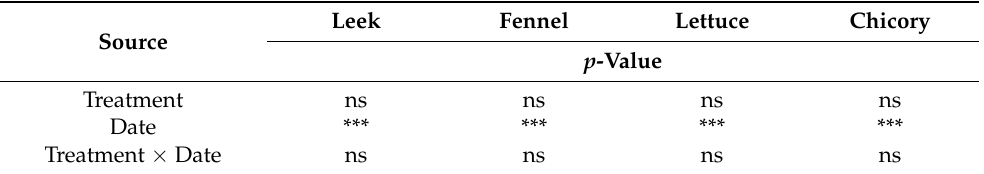
Table 2. Results of analysis of variance testing the effects of the independent variables treatment, date and their interaction on green cover percentage of the four